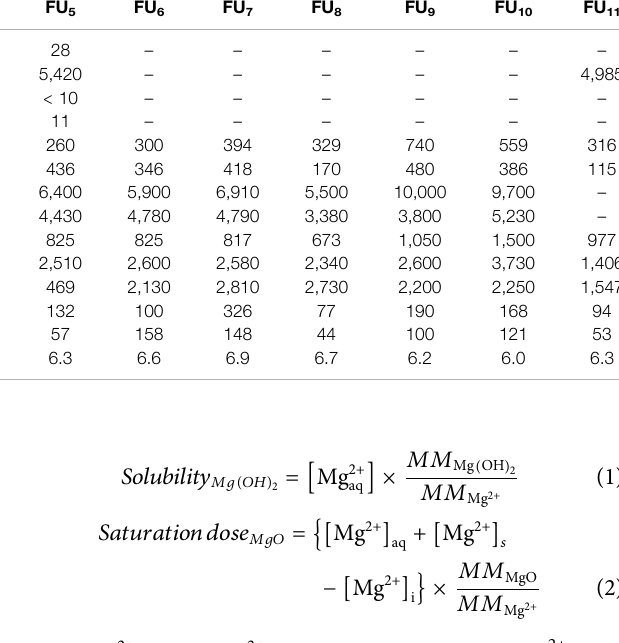
TABLE1| Compositionoffreshurinesamples.ThecompositionsFU 1 ,FU 2 ,FU 3 andFU 4 weremeasuredinthisstudy,whileFU 5 ,FU 6 ,FU 7 andFU 8 weretakenfromRandall et al. (2016), FU 9 from Udert et al. (2006), FU 10 from Udert et al. (2003) and FU 11 from Vasiljev et al. (2022). Measurement